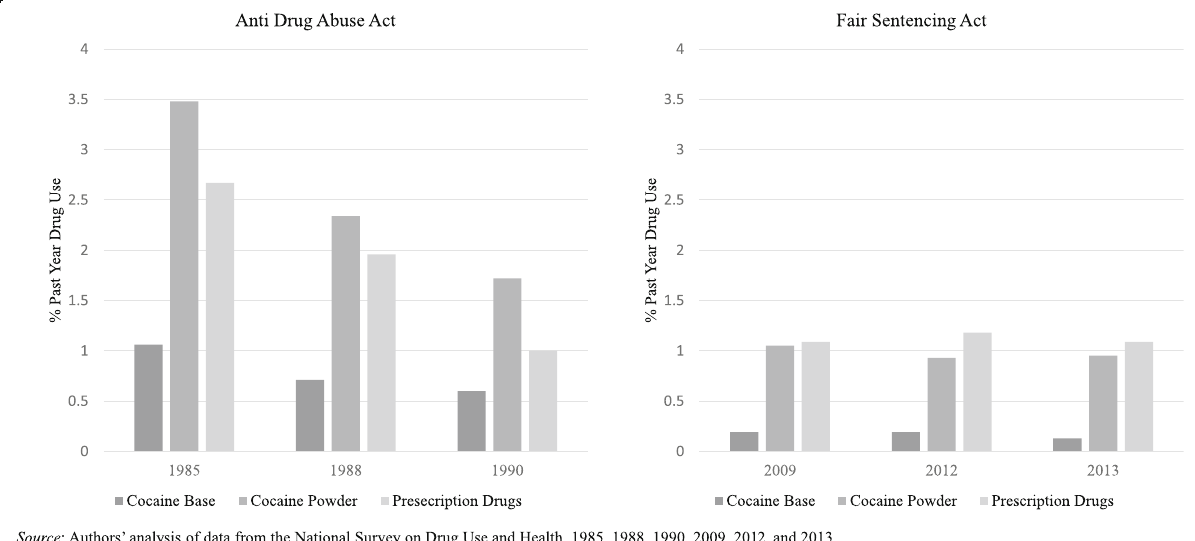
Fig. 1 Drug use trends during the ADAA and FSA periods